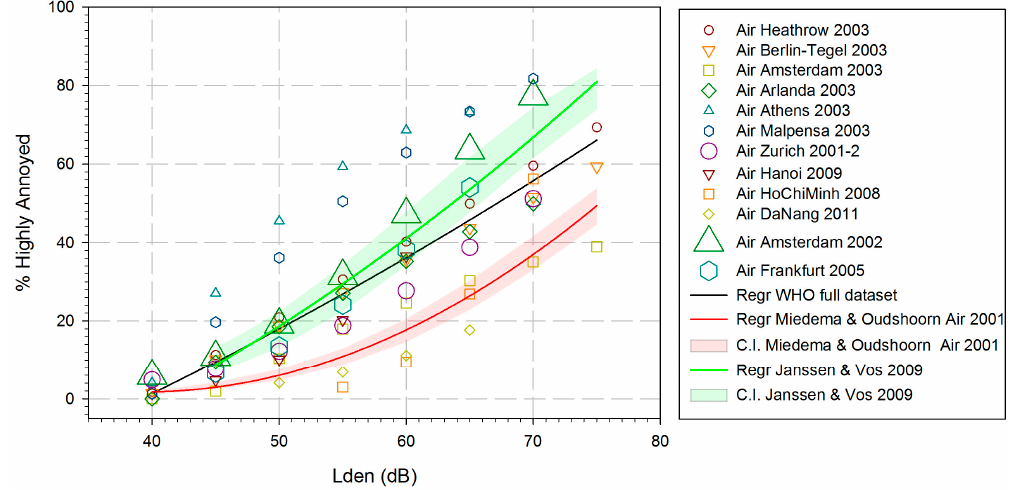
Figure 2. Scatterplot and quadratic regression of the relation between L den and the calculated %HA for 12 aircraft noise studies, together with ERFs by Miedema and Oudshoorn ([4], red), and Janssen and Vos ([20], green). Notes: (1) The size of the data points corresponds to the number of participants in the respective study (size = SQRT(N)/10). (2) If two results from different studies fall on the same data point, the last point plotted may mask the former one. (3) The black curve is derived from aggregated secondary data, while the red and green curves are derived from individual data. In addition, the mathematical models used for establishing the three functions differ.